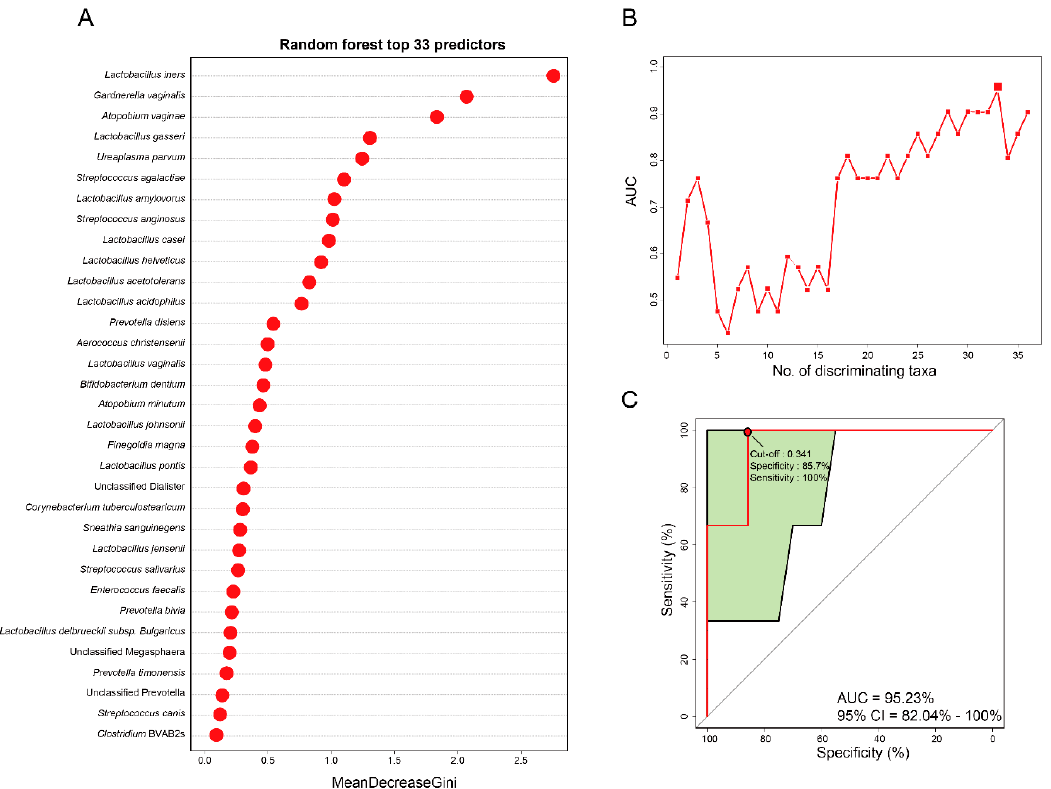
Figure 4. Random forest classifier model using vaginal microbiome-derived bacterial signatures to predict the severity of CIN. ( A ) The 33 most important bacterial species based on their mean decrease Gini scores of the optimal random forest model. ( B ) The 33 bacterial species selected by optimizing the area under the curve (AUC) of the receiver operating characteristics (ROC) curve. ( C ) The AUC of vaginal microbiome-based classification. Random forest classifiers were used to predict CIN 1 − and CIN 2+ based on species-level vaginal microbiome composition. The green area of the curve represents the 95% confidence interval (CI) shape.